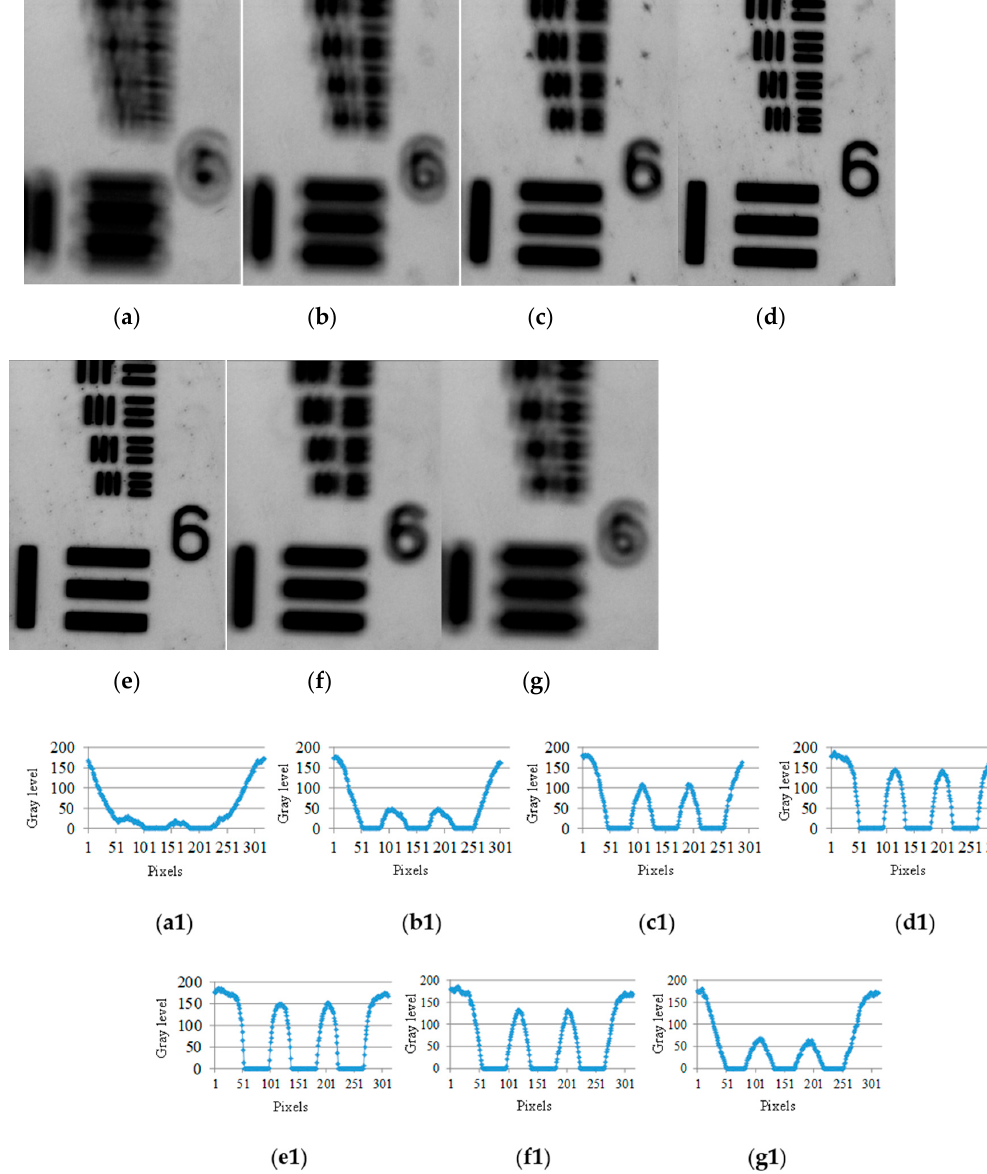
Figure 7. ( a )–( g ) Images of resolution target obtained by focusing system with di ff erent defocusing Figure 7. (a)– ( g ) Images of resolution target obtained by focusing system with different defocusing states, ( a1 )–( g1 ) Intensity profile at group 6 element 1 of each image with di ff erent defocusing states, (a1)– ( g1 ) Intensity profile at group 6 element 1 of each image with different defocusing states.